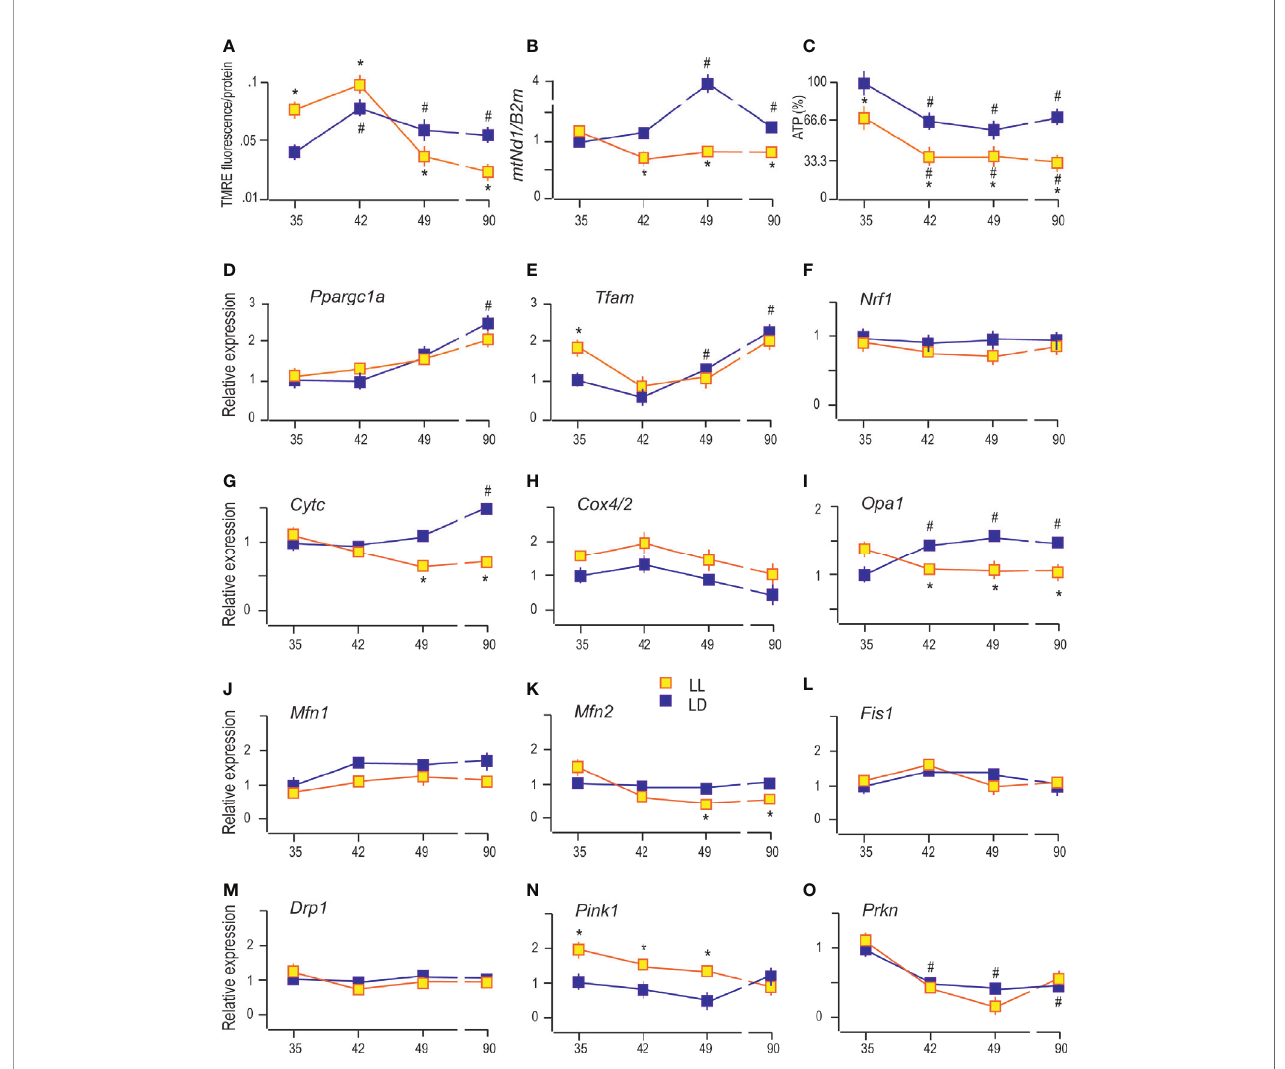
FIGURE 4 | Constant light changed Leydig cell ’ s mitochondrial function. The D y m was measured by using TMRE fl uorescence (A) , followed by monitoring of mtDNA content estimated through mtNd1/B2m ratio (B) and analysis of ATP levels (C) in puri fi ed Leydig cells isolated from rats of different ages of both (LD and LL) groups. Also, transcriptional patterns of genes important for mitochondrial biogenesis (D – F) , genes encoding subunits of respiratory proteins (G, H) , mitochondrial fusion (I – K) , mitochondrial fi ssion (L, M) and mitophagy (N, O) were monitored in the same cells. Data points represent group means ± SEM values (n = 5). *Statistical signi fi cance at level p < 0.05 compared to the corresponding LD group; # Statistical signi fi cance at level p < 0.05 compared to the P35 LD